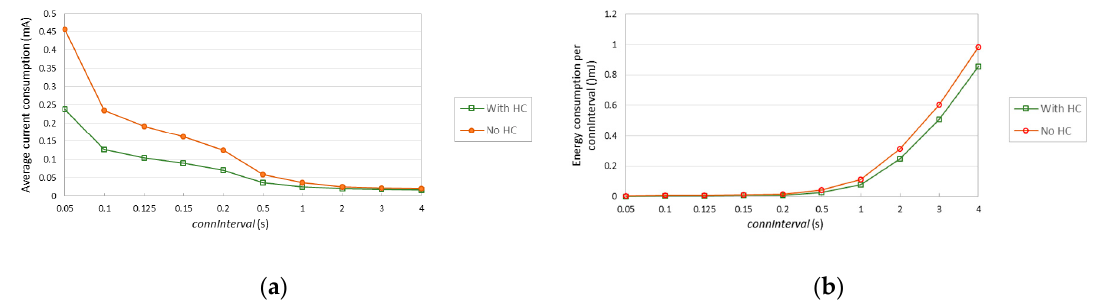
Figure 18. Performance results for a 58-byte IPv6 packet, with and without header compression (HC), for a PCA10028 6LN: ( a ) Average current consumption for different connInterval settings; ( b ) for a PCA10028 6LN: ( a ) Average current consumption for di ff erent connInterval settings; ( b ) energy energy consumption during a connection interval. consumption during a connection interval.